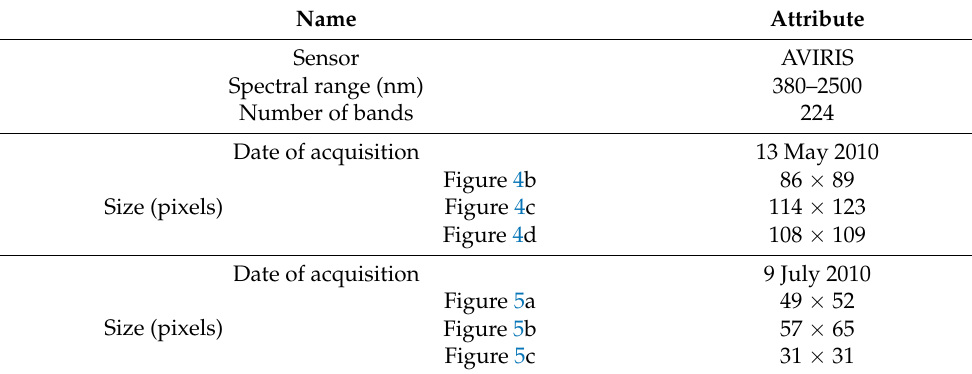
Table 1. Main parameters of images in Figures 4 and 5.